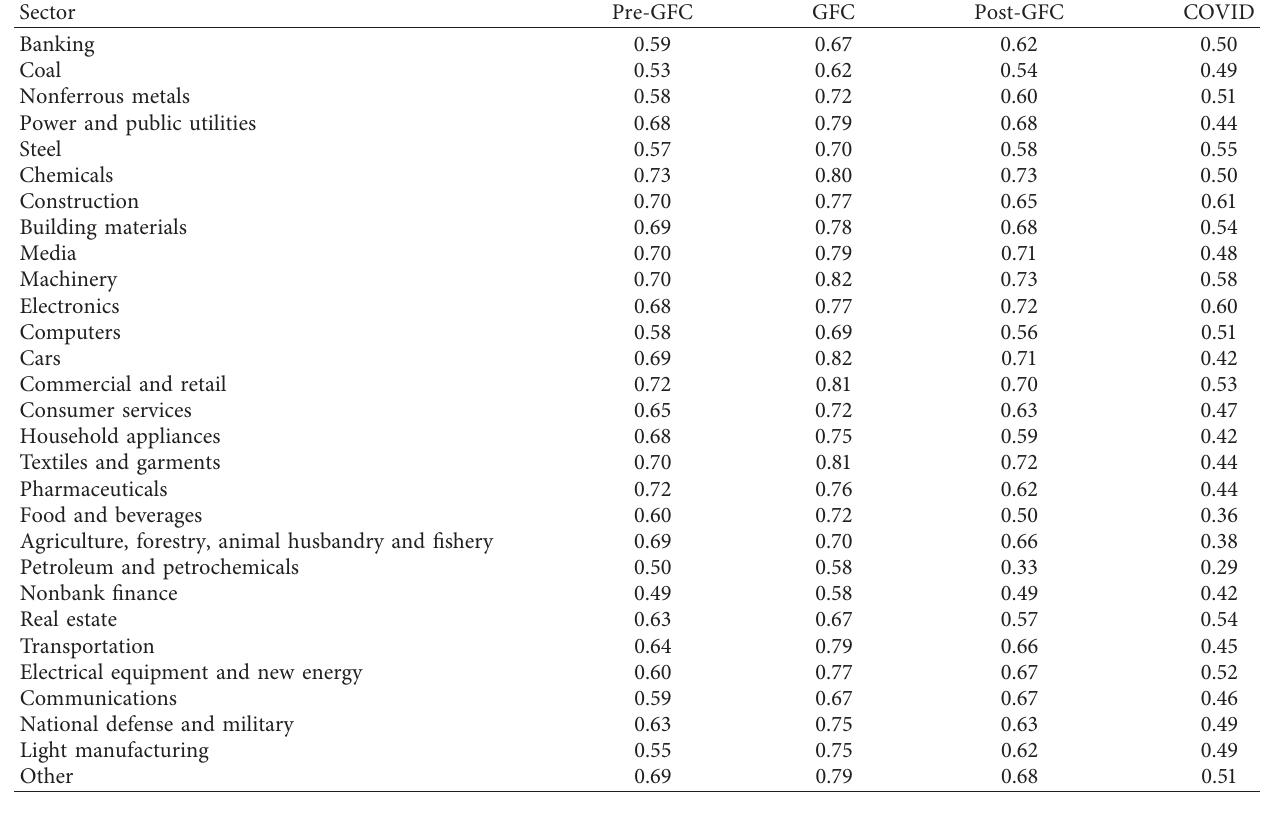
Table 2: Dependence coefficients of 29 industrial sectors in four